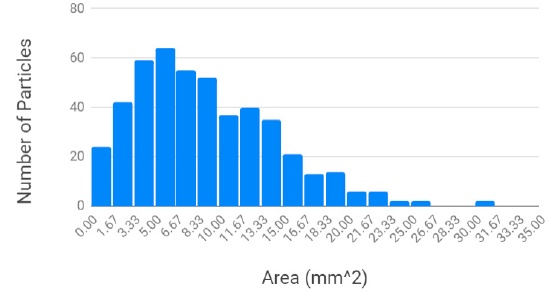
Figure 9. Particle size distribution of rPET water bottle flake sifted, then heated at 190 °C for 5